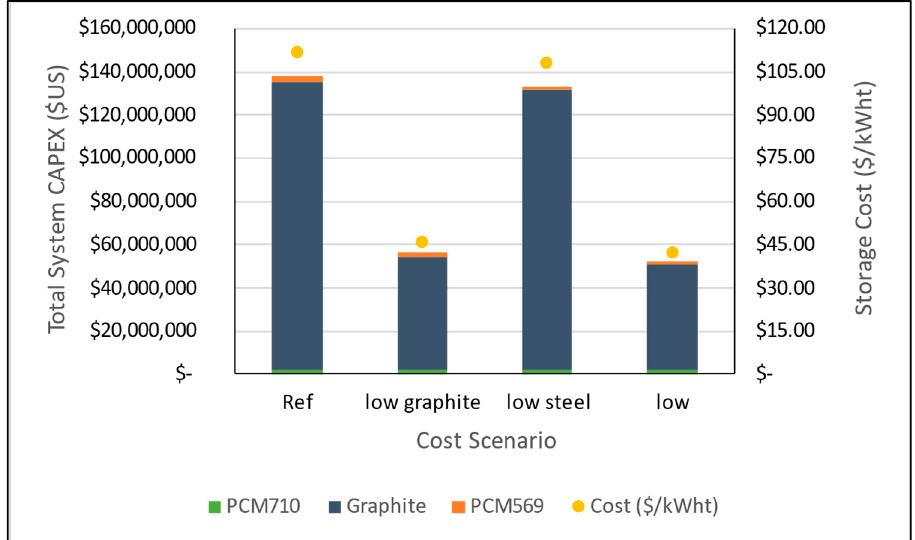
Figure 8. CAPEX Variation with Material Costs.